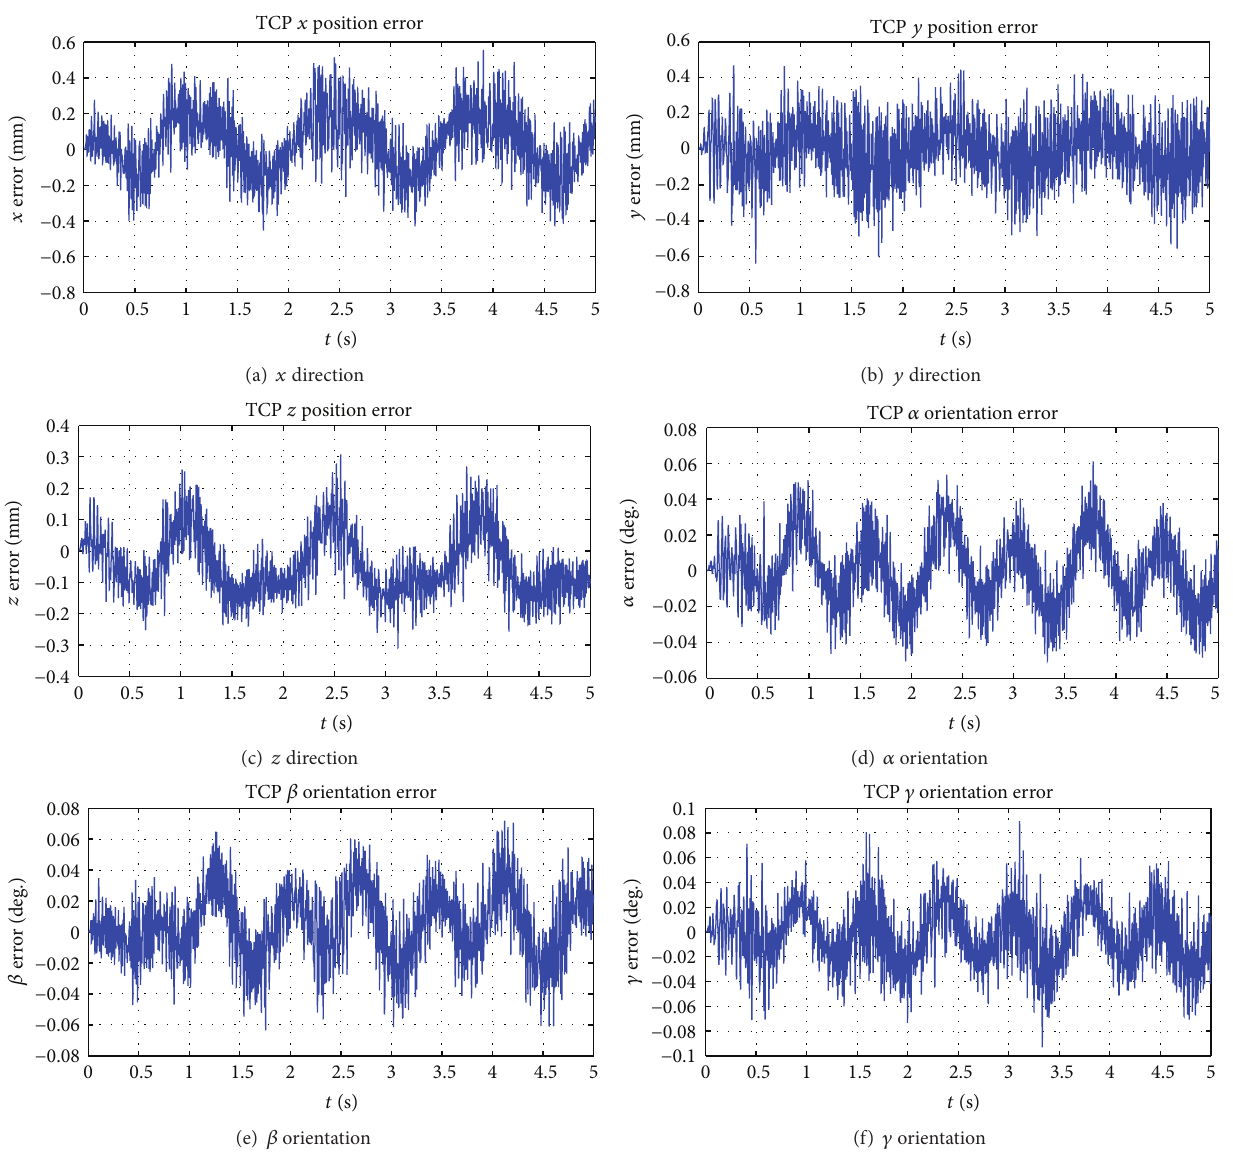
Figure 11: Pose error of the platform when adaptive-robust control is used.